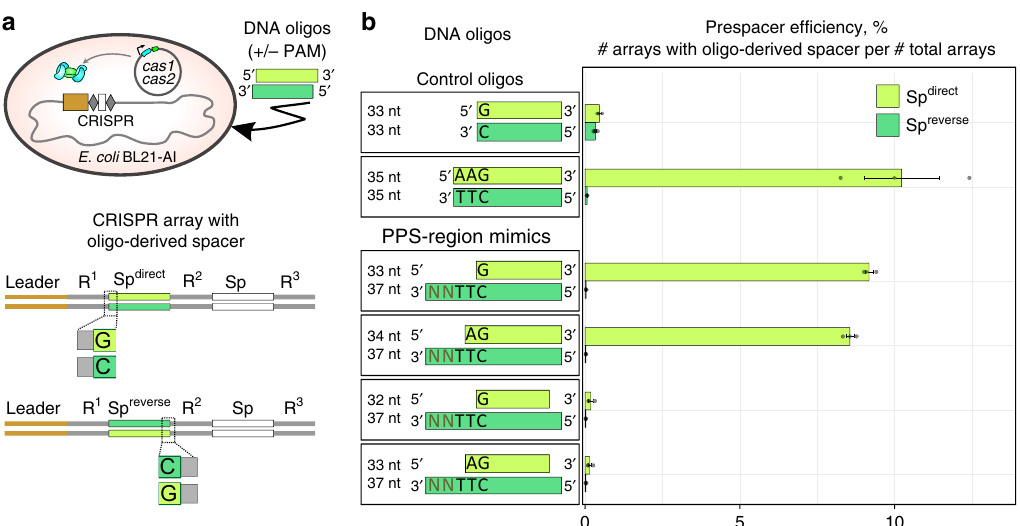
Fig. 3 Synthetic mimics of DNA fragments detected in cells undergoing primed adaptation function as prespacers. a Prespacer ef fi ciency assay. Top, introduction of synthetic DNA into cells containing a CRISPR array and plasmid that directs expression of cas1 and cas2 . Bottom, integration of synthetic DNA into the CRISPR array occurs in either a direct (Sp direct ) or reverse (Sp reverse ) orientation. b Results. Left, oligonucleotides analyzed. Right, percentage of arrays containing oligo-derived spacers having a direct (light green) or reverse (dark green) orientation (mean ± SEM of three biological replicates). Source data are provided as a Source Data fi